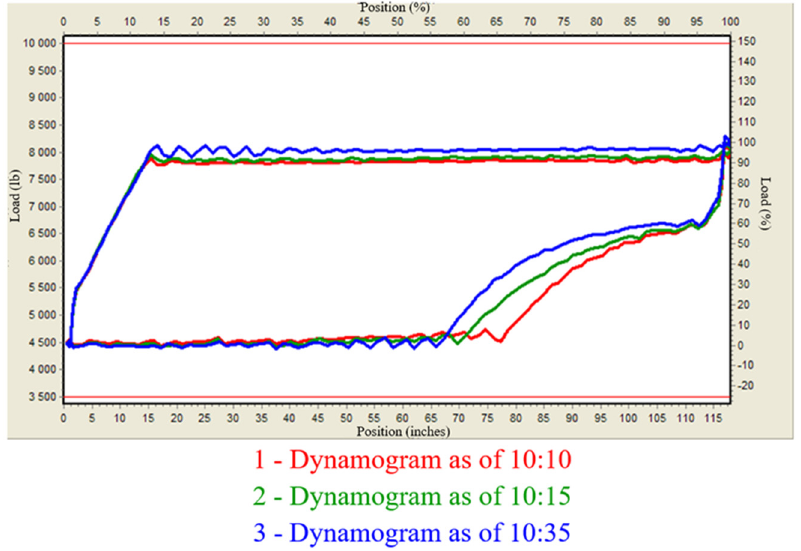
Figure 9. The history of gas impact on the operation of the sucker-rod pump in case of rapid extraction of annular gas.